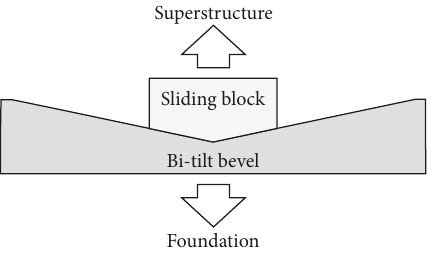
Figure 2: Configuration of a Bi-Tilt